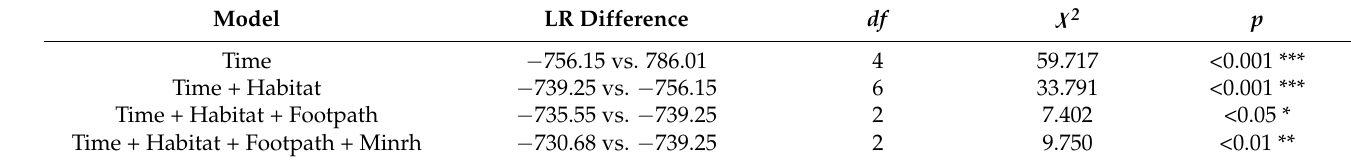
Table 4. Likelihood Ratio (LR) tests predicting dog ( Canis lupus familiaris ) relative abundance across 7 study sites in Brighton and Hove and surrounding areas, England, UK. Each LR comparison and ꭕ 2 value is for the model listed in each case against the previous model in the row above except for Time only, which is tested against the null model (dog~1). Time = time of day (morning, day, evening); Habitat = habitat type (hardstanding, amenity grassland, natural grassland, woodland/scrub); Footpath = location on/off a footpath; Minrh = minimum relative humidity (%). * < 0.05; ** < 0.01; *** < 0.001.